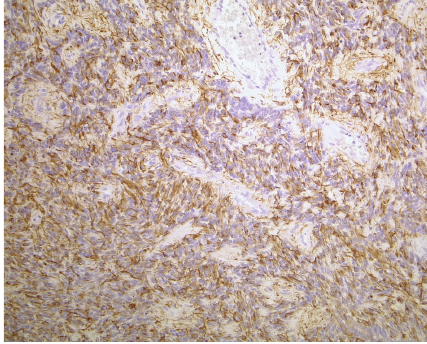
Figure 5: Tumor cell processes were GFAP-positive and built up perivascular pseudorosettes (anti-GFAP, ABC, × 200, original magnification).